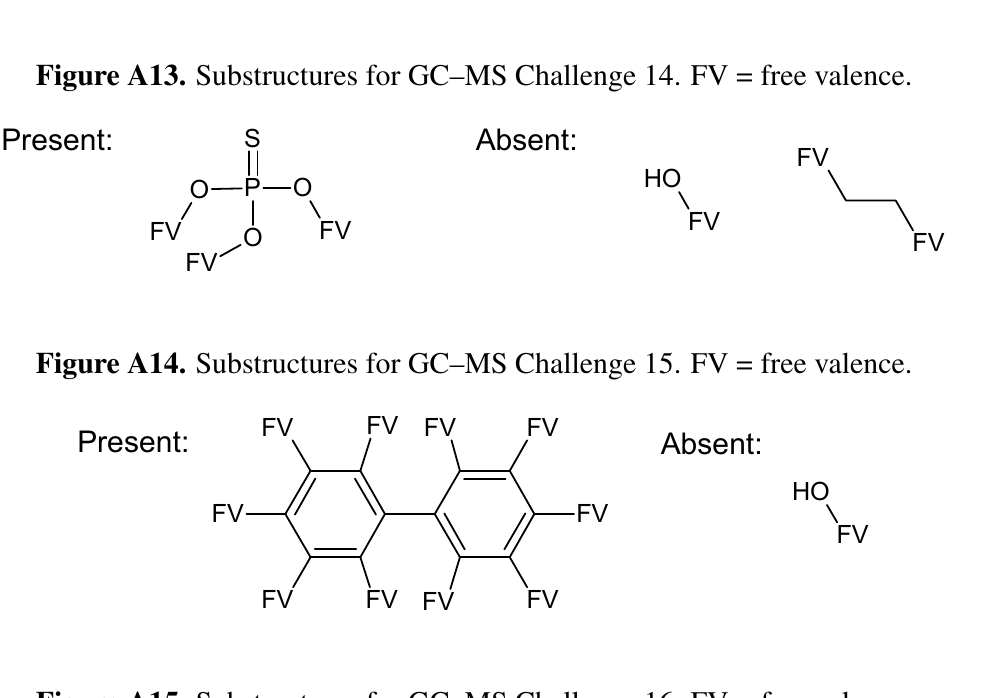
Figure A15. Substructures for GC–MS Challenge 16. FV = free